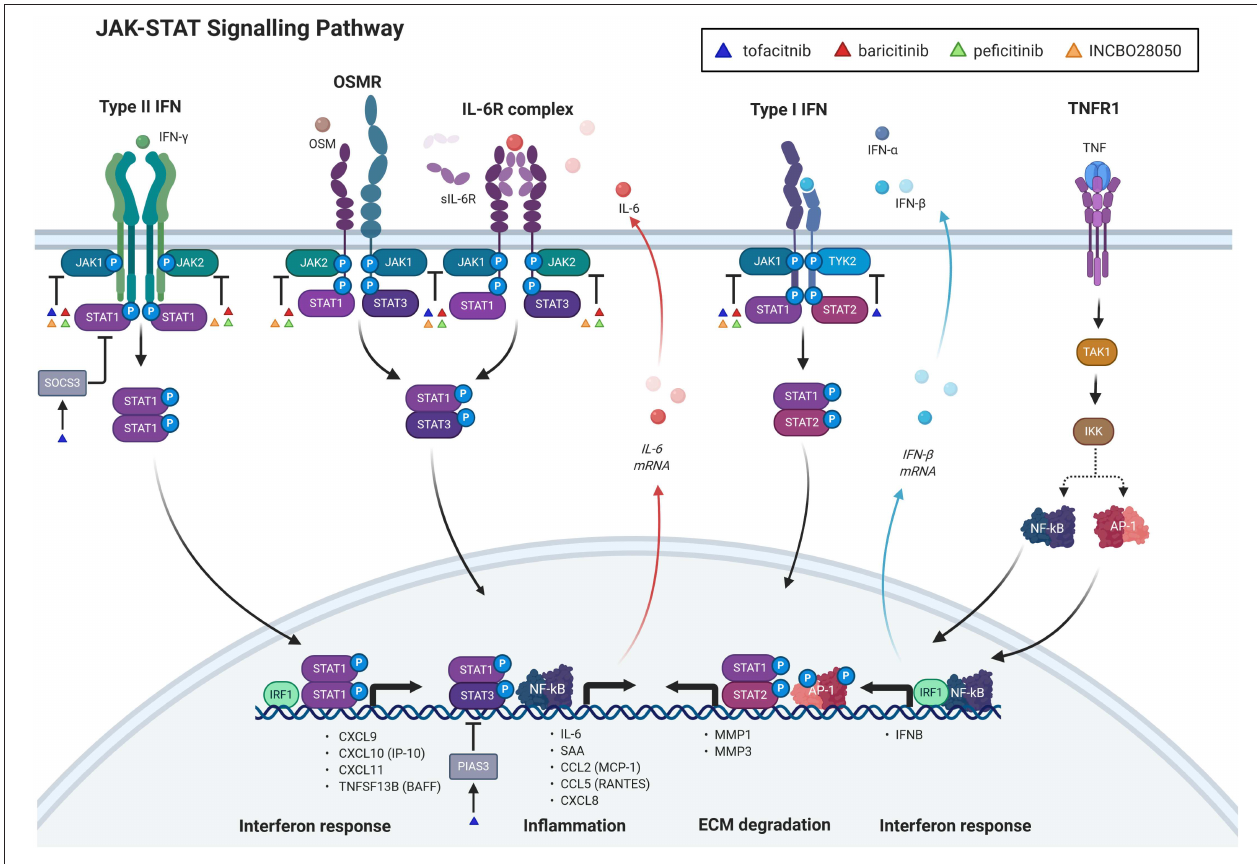
FIGURE 1 | Janus kinase (JAK)-Signal transducer and activator of transcription (STAT) signaling pathway and its inhibition with jakinibs in synovial fibroblasts. The figure shows direct and indirect signaling pathways, involved in the JAK-STAT signaling and their targeting with jakinibs in synovial fibroblasts. Only pathways with mechanistic evidence and jakinibs with experimental evidence in synovial fibroblasts are included in the figure. Upadacitinib has not yet been experimentally explored in synovial fibroblasts and is therefore not shown in the figure. Direct signaling through the JAK-STAT pathway can be induced with type I and type II interferons (IFN) and interleukin-6 (IL-6) family cytokines [oncostatin M (OSM), IL-6] upon ligating their respective receptors. This is followed by auto-phosphorylation of distinct JAKs that phosphorylate specific subsets of STATs. Tumor necrosis factor (TNF) indirectly activates the JAK-STAT pathway by increasing the release of IL-6 and IFN beta (IFN β ) from synovial fibroblasts with subsequent autocrine activation of IL-6 family and IFN Type I receptor complexes, respectively. sIL-6R: soluble IL-6 receptor; TNFR1: TNF receptor 1; IFN α : interferon alpha; NF- κ B: nuclear factor-kappa B; AP-1: activator protein 1; TAK1: transforming growth factor beta-activated kinase 1; IKK: inhibitory kappa B kinase; SOCS3: suppressor of cytokine signaling 3; IRF1: interferon response factor 1; CXCL8-11: chemokine (C-X-C motif) ligand 8–11; IP-10: IFN- γ -inducible protein 10; TNFSF13B: tumor necrosis factor ligand superfamily member 13B, also known as BAFF, BAFF: B-cell activating factor; PIAS3: protein inhibitor of activated STAT3; CCL2: chemokine (C-C motif) ligand 2; MCP-1: monocyte chemoattractant protein 1; SAA: serum amyloid A; MMP 1,3: matrix metalloproteinase 1,3; ECM: extracellular matrix; INCBO28050: baricitinib. The figure was created with